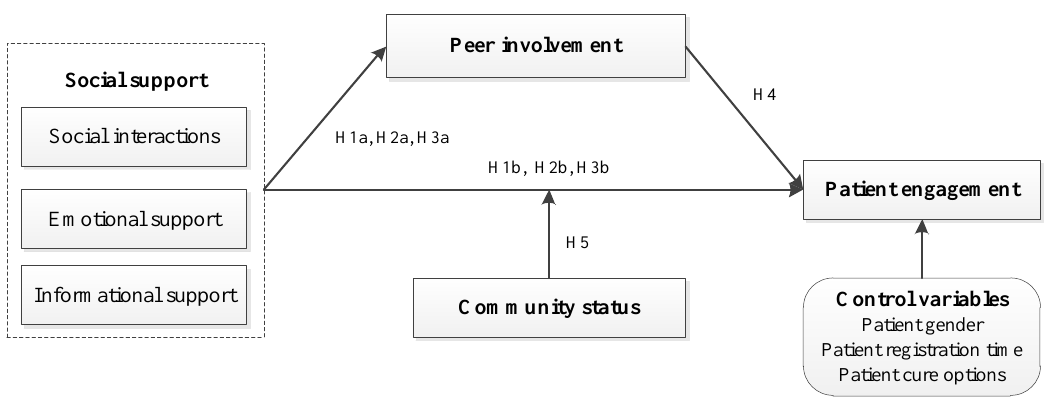
Figure 1. Research